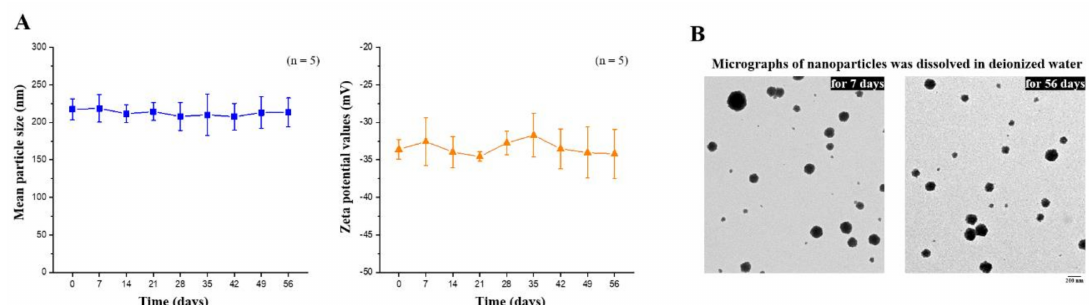
Figure 4. ( A ) Mean particle size and zeta potential values of EGCG-loaded nanoparticles were recorded for 56 days. Data are expressed as means ± SDs ( n = 5); ( B ) Transmission electron microscopy micrographs of EGCG-loaded nanoparticles were observed after storage for 7 or 56 days. Scale bar: 200 nm.